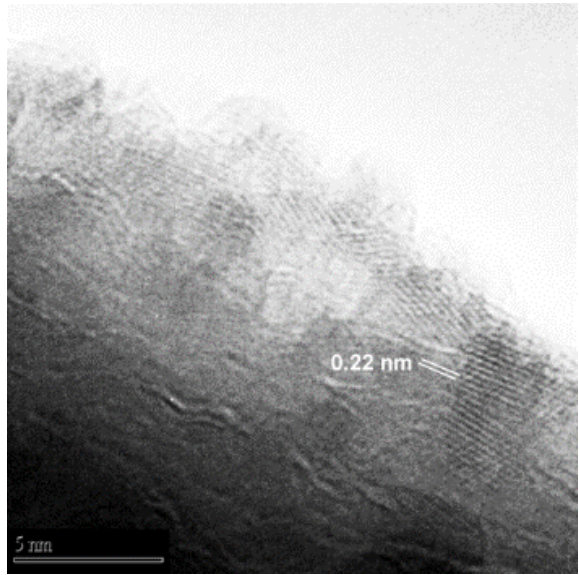
Figure 8. HR-TEM image of a nanowire produced on the C-Mg annealed powder sample.